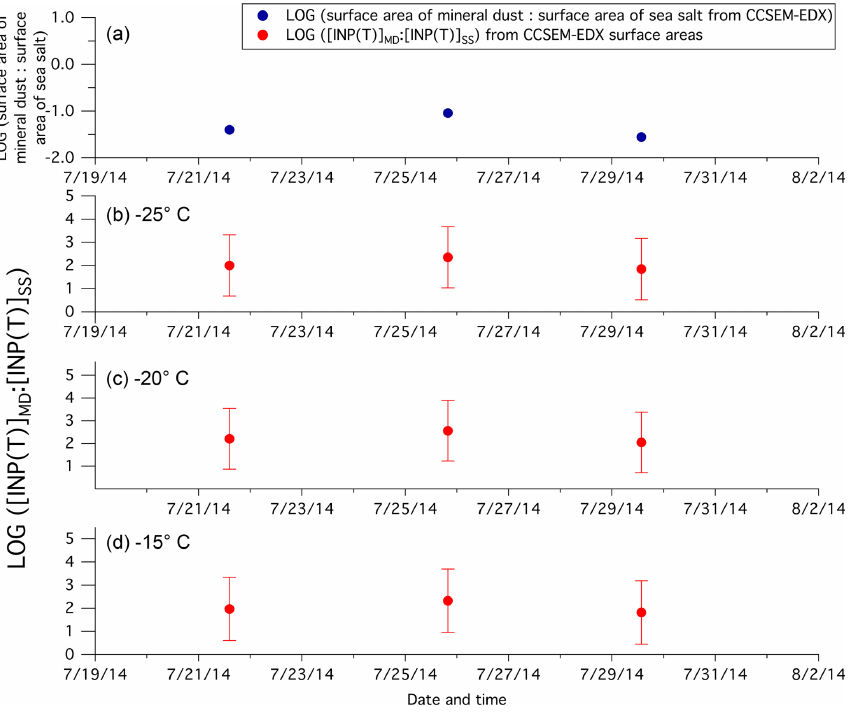
Figure 14. Results from measurements in the Arctic marine boundary layer during summer 2014 (Irish et al., 2019). (a) Ratios of the surface area of mineral dust particles to the surface area of sea salt particles measured by computer controlled scanning electron microscopy with energy-dispersive X-ray spectroscopy (CCSEM-EDX). Ratios of predicted INP concentrations from mineral dust, [INP(T)] MD , to the predicted INP concentrations from sea spray aerosol, [INP(T)] SS , are calculated using CCSEM-EDX measurements at temperatures of (b) − 25 ◦ C, (c) − 20 ◦ C, and (d) − 15 ◦ C. Results show that mineral dust is a more important contributor to the INP population in the Arctic than sea spray aerosol at these times and